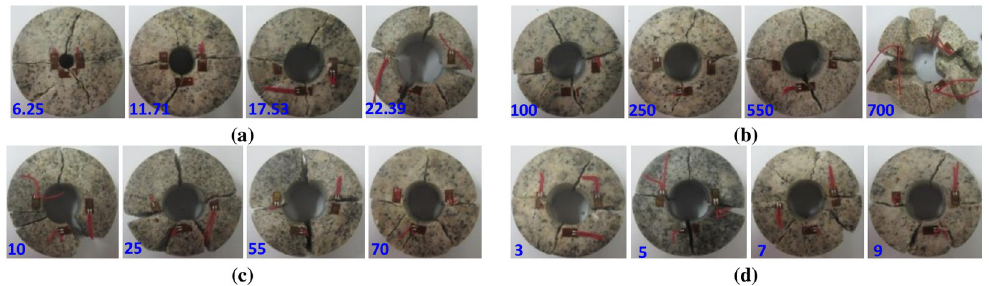
Fig 9. Failure modes of circular granite under radial impact loads. (a) Different ring inner diameters (Units: mm). (b) Different heating temperatures (Units: ˚C). (c) Different curing temperature s (Units: ˚C). (d) Different cycle heat recovery times (Units: